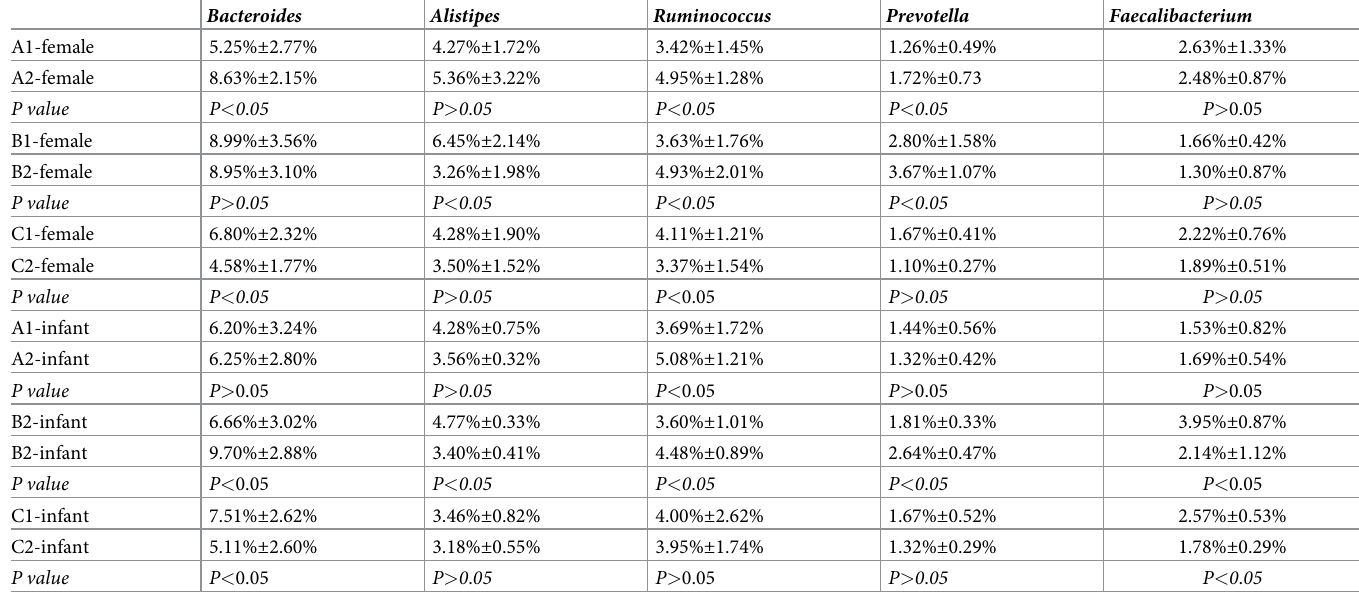
Table 2. Differences in the five most abundant genera of intestinal microbiota in female and infant FMD at different separation times (A: 80 days, B: 90 days, C: 100 days) as well as before (1) and after (2)